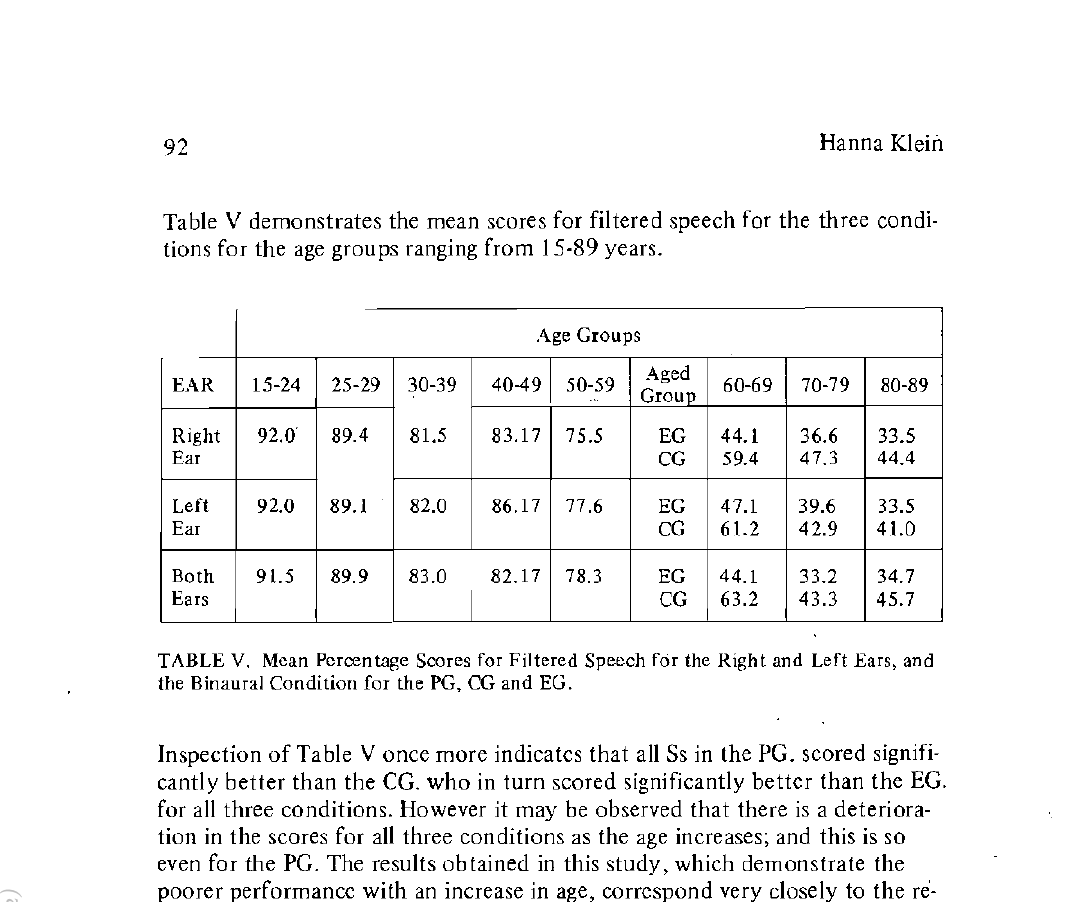
Table V demonstrates the mean scores for filtered speech for the three condi- tions for the age groups ranging from 15-89 years.